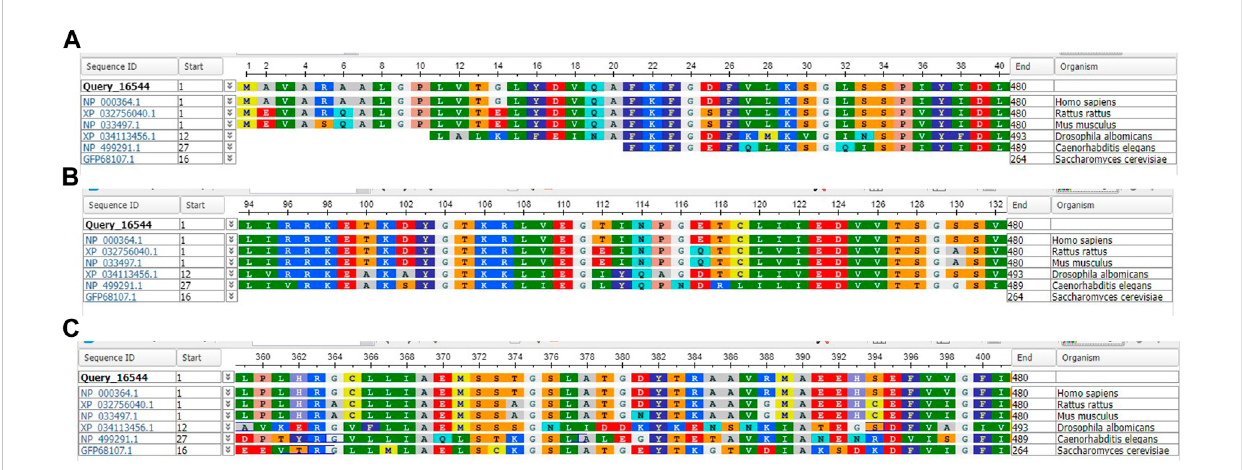
FIGURE 1 StandardProteinBLASTandalignmentofuridine5 ′ -monophosphatesynthase[ Homosapiens , Rattusrattus , Musmusculus , Drosophila albomicans] andOrotidine5 ′ -phosphatedecarboxylase[ Caenorhabditiselegans , Saccharomycescerevisiae ]. (A) Aminoacidrange1 – 40including8 L. (B) Aminoacid range 94 – 132 including 114 N (C) Amino acid range 359 – 401 including 378